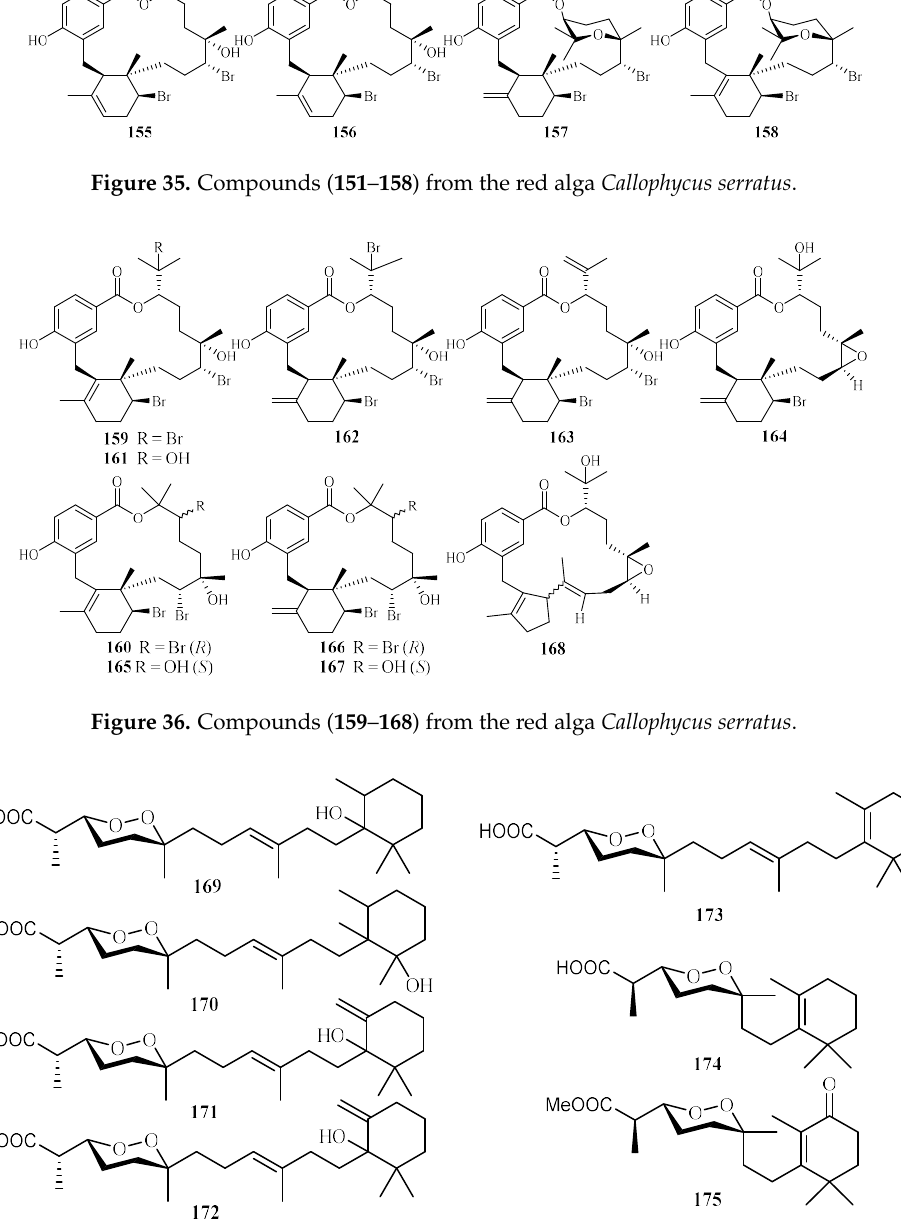
Figure 37. Compounds from the sponge Diacarnus megaspinorhabdosa .